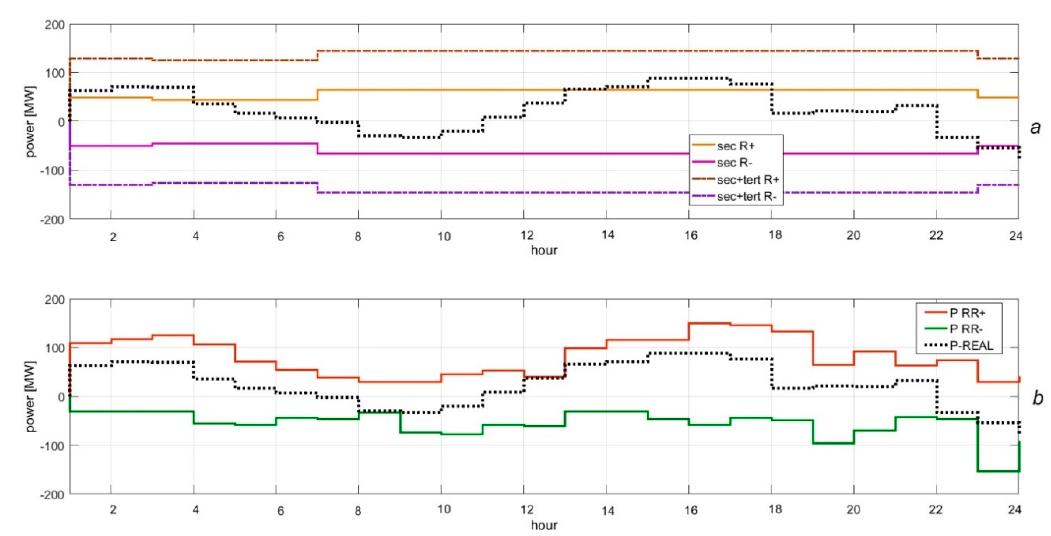
Figure 6. Reserve scheduling for August 15, 2015; ( a ) classic approach, ( b ) proposed approach.